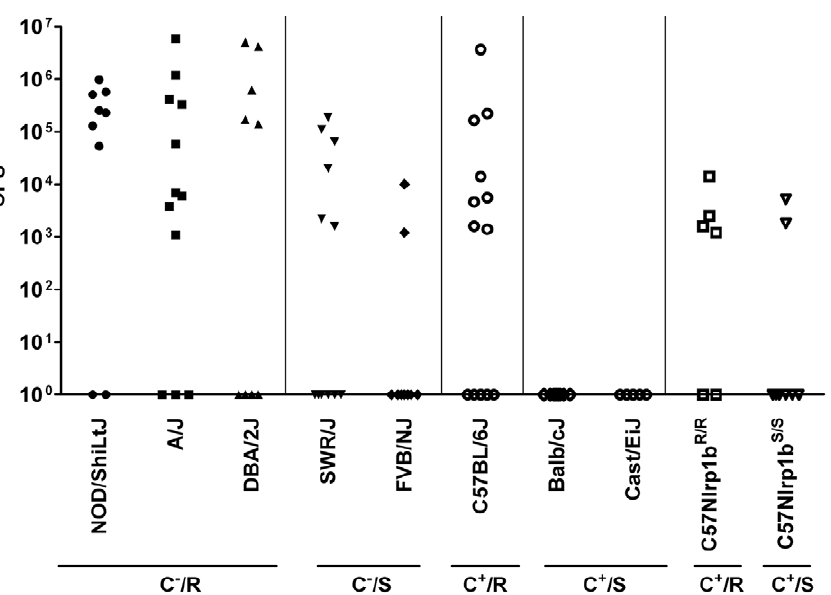
Figure 2. Bacterial CFU counts in organs following spore infection. Mice were injected with 2 6 10 7 spores (SC) and spleen, liver and kidneys were harvested at 24–32 h, pooled, and the bacterial numbers (CFU/mouse) in the combined organs were assessed by dilution plating. C + , C 2 , R, and S designations are as in Fig. 1. Results represent three independent experiments and n values are n=9 for all strains except A/J (n=12), SWR/J (n=12), C57BL/6J (n=13), CAST/EiJ (n=5), C57BL/6NTac Nlrp1b R/R (n=6) and C57BL/6NTac Nlrp1b S/S (n=8). F-test (which compares the variance between groups) yields values . 0.05 comparing all groups except the following, which have significant variance ( , 0.05): NOD/ShiLtJ vs. SWR/J, FVB/ NJ, C57BL/6J, Balb/cJ and Cast/EiJ, C57BL/6NTac Nlrp1b S/S , C57BL/6NTac Nlrp1b R/R ; A/J vs. SWR/J, FVB/NJ, Balb/cJ and Cast/EiJ, C57BL/6NTac Nlrp1b S/S , C57BL/6NTac Nlrp1b R/R ; DBA/2J vs. Balb/cJ and Cast/EiJ, C57BL/6NTac Nlrp1b S/S , C57BL/6NTac Nlrp1b R/R ; SWR/J vs. every group; FVB/NJ vs. every group except C57BL/6NTac Nlrp1b S/S and C57BL/6NTac Nlrp1b R/R ; C57BL/6J vs. every group except A/J and DBA/2J. Balb/cJ and Cast/EiJ compared to every group except C57BL/6NTac Nlrp1b S/S . The P-value comparing variance between C57BL/6NTac Nlrp1b S/S and C57BL/6NTac Nlrp1b R/R is 0.0145.